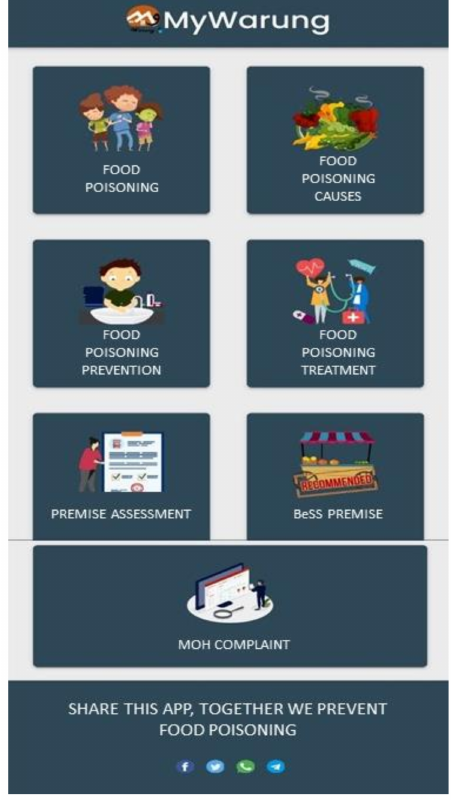
Figure 3. Landing page of developed MyWarung© mobile